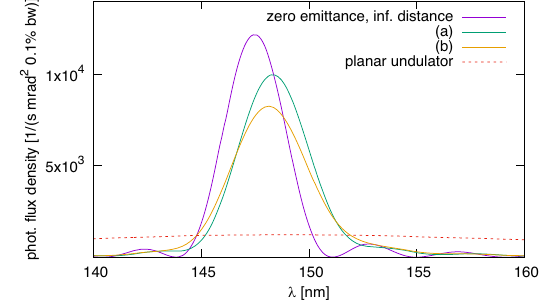
FIG. 15. Radiation spectra expected for the real SCTGU-P40 with finite beam emittance and observation at 2 m distance with (a) a photon optics for a parallel beam (zero angular acceptance) and (b) a point detector. The corresponding zero-emittance and planar undulator spectra in forward direction (parallel beam) are added for comparison. For the undulator and beam parameters refer to Table II of the original